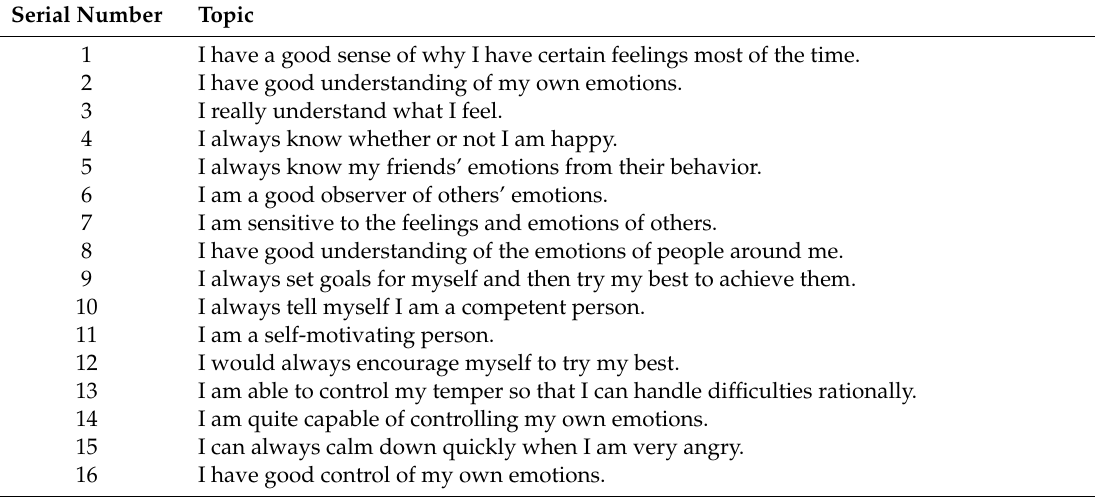
Table A2. Emotional Intelligence